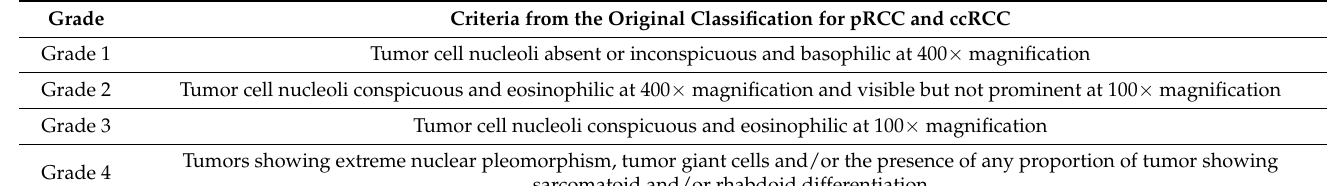
Table 2. The WHO/ISUP grading system for pRCC and ccRCC, adapted from [38]. Criteria from the Original Classification for pRCC and